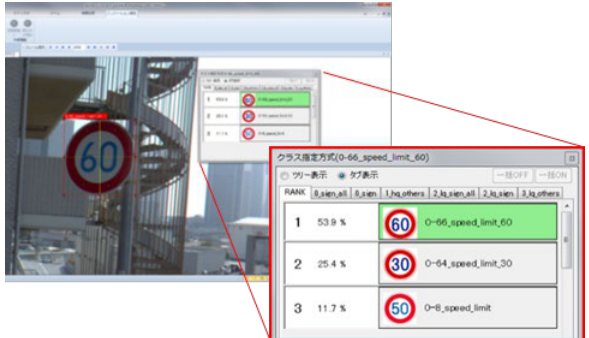
Figure 10. Example of display with a ranking list